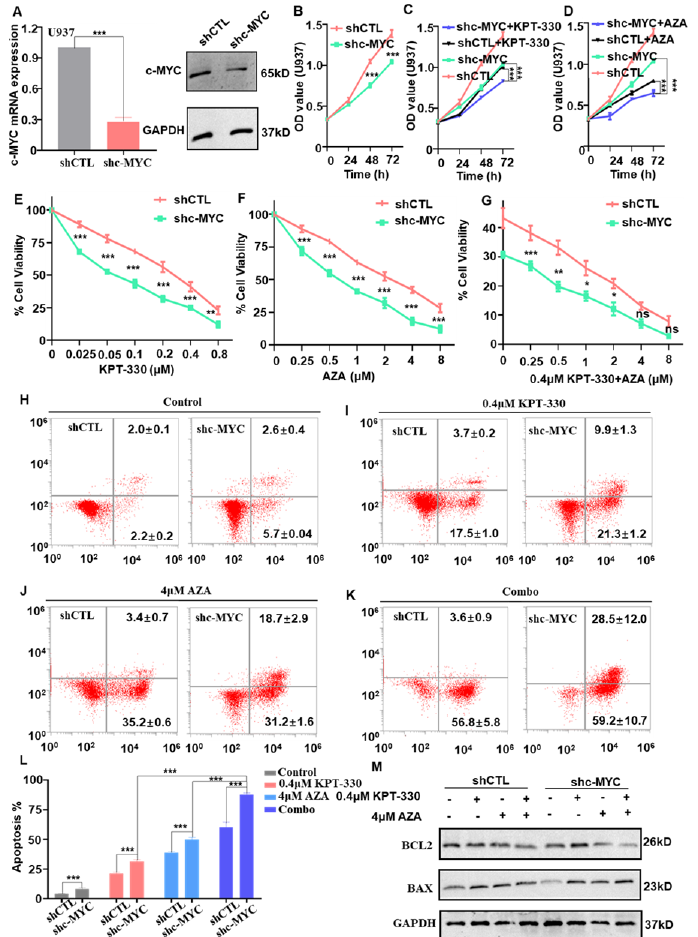
Figure 4. Effect of c-MYC knockdown on the combination-mediated proliferation in U937 cells. ( A ) c-MYC was efficiently knocked down in the U937 cell by qPCR and western blot. ( B ) c-MYC knockdown (shc-MYC) inhibits cell proliferation arrest compared to that of scramble shRNA (shCTL) in U937 cells. ( C , D ) The effect of c-MYC knockdown by shRNA with XPO1 inhibitor or AZA on